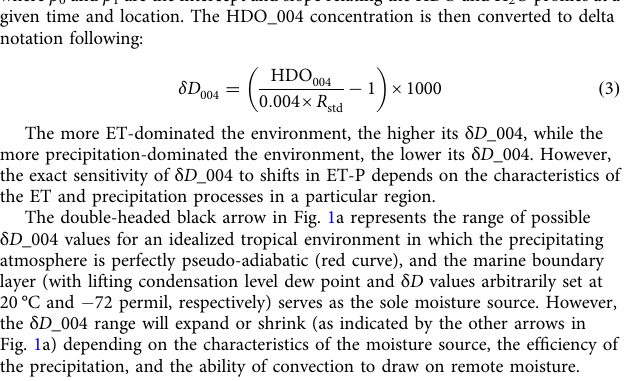
One factor that will extend the upper end of the δ D _004 range, for example, is the relative contribution of transpiration to the total ET fl ux (green arrow). Because transpiration, on balance, produces almost no isotopic fractionation, the δ D _004 range of tropical terrestrial environments will extend towards the green curve in Fig. 1. The low end of the δ D _004 range tends to depend on the characteristics of precipitation. If, as is typical, the ef fi ciency with which cloud water forms precipitation is less than 100% 54 , isotopic depletion during precipitation will not be as great (pink arrow). However, if rain evaporation occurs, reducing the ef fi ciency with which precipitation reaches the surface, and if the evaporated fraction of the rain is small, the isotopic depletion will be larger (purple arrow). Importantly, evaporation has a depleting effect on the vapor only if the rain evaporated fraction is very small ( fi rst order approximation in Worden et al. 2007). Otherwise, rain evaporation has an enriching effect on the water vapor 55 – 57 . Microphysical processes within different regions of the atmospheric pro fi le may thus have somewhat canceling effects on the δ D _004 sensitivity to ET-P. In comparison, the convergence of remote moisture unambiguously extends the δ D _004 range to lower values (Fig. 1, orange arrow) 17 . Greater isotopic depletion is the result of convection incorporating ever-more rained out moisture. Indeed, idealized modeling studies indicate that the degree to which convection relies on remote moisture (as opposed to local ET) is an important factor determining tropical precipitation isotope ratios 58 . Consequently, one might expect that regions of the Amazon that lie farthest inland, whose local moisture is sourced from vegetated surfaces 3,5 , and whose non-local moisture must travel a longer distance from the Atlantic coast, are more likely to exhibit a larger δ D _004 sensitivity to shifts in ET-P. This suspicion is supported by the enhanced range in precipitation isotope ratios found over inland areas of the Amazon Basin (compared to coastal areas) between the precipitation-dominated wet and evaporation-dominated dry seasons 59